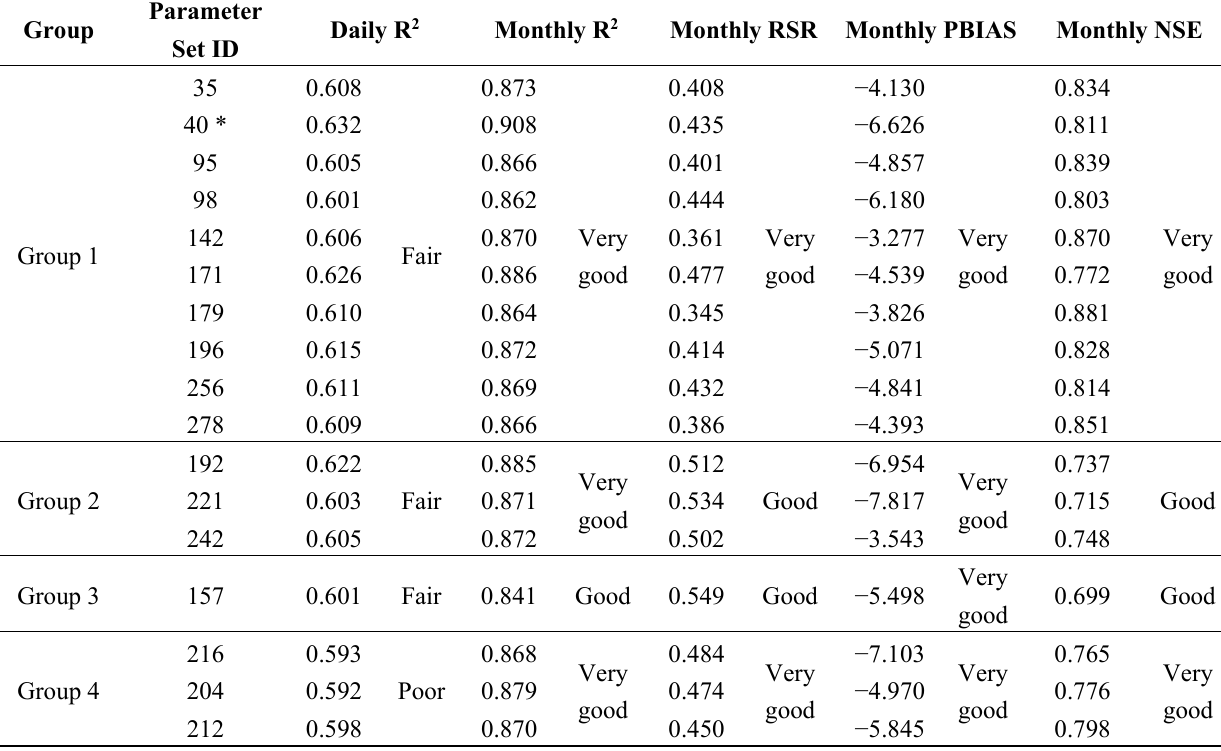
Table 5. Classification of the parameter sets identified by HSPF-SCE in terms of model performance statistics (for the Reed Creek watershed). Group